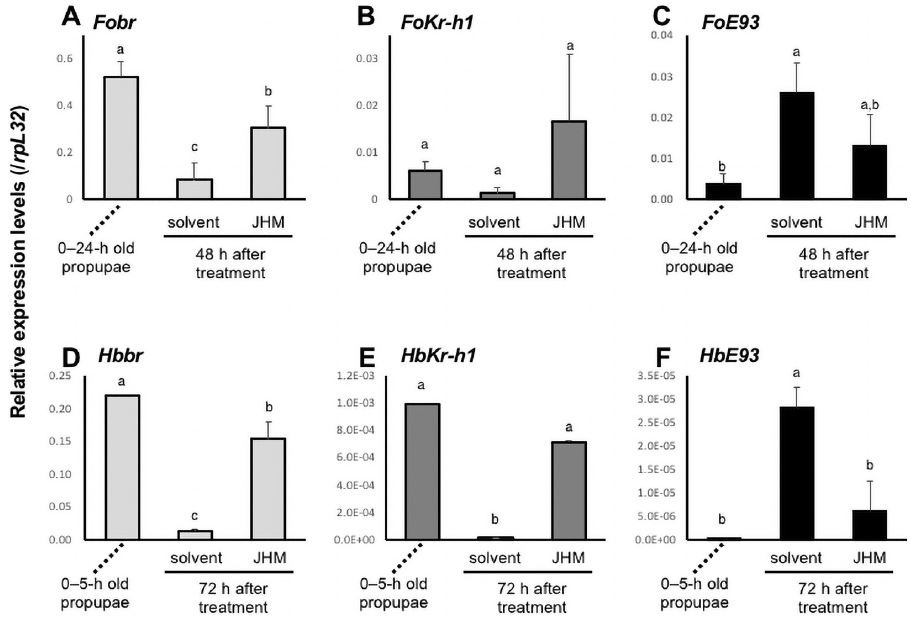
Fig 2. Transcript levels of br , Kr-h1 , and E93 after JHM (10 mM pyriproxyfen) treatment. Means with the same letter are not significantly different (Tukey–Kramer test, P < 0.05). (A–C) Newly molted “propupae” of F . occidentalis were treated with JHM or solvent only, and the Fobr (A), FoKr-h1 (B), and FoE93 (C) transcripts were quantified 48 h later. Pools of 4–7 animals were used for RNA isolation in each replicate, and means and standard deviations from 4 biological replicates are shown. The values were normalized to those of ForpL32 . The transcript levels in 0–24 h-old “propupae” were also shown. (D–F) Newly molted “propupae” of H . brevitubus were treated with JHM or solvent only, and the Hbbr (D), HbKr-h1 (E), and HbE93 (F) transcripts were quantified 72 h later. Pools of 8–11 animals were used for RNA isolation in each replicate, and means and standard errors from 2 biological replicates are shown. The values were normalized to those of HbrpL32 . The transcript levels in 0–5 h-old “propupae” are also shown.